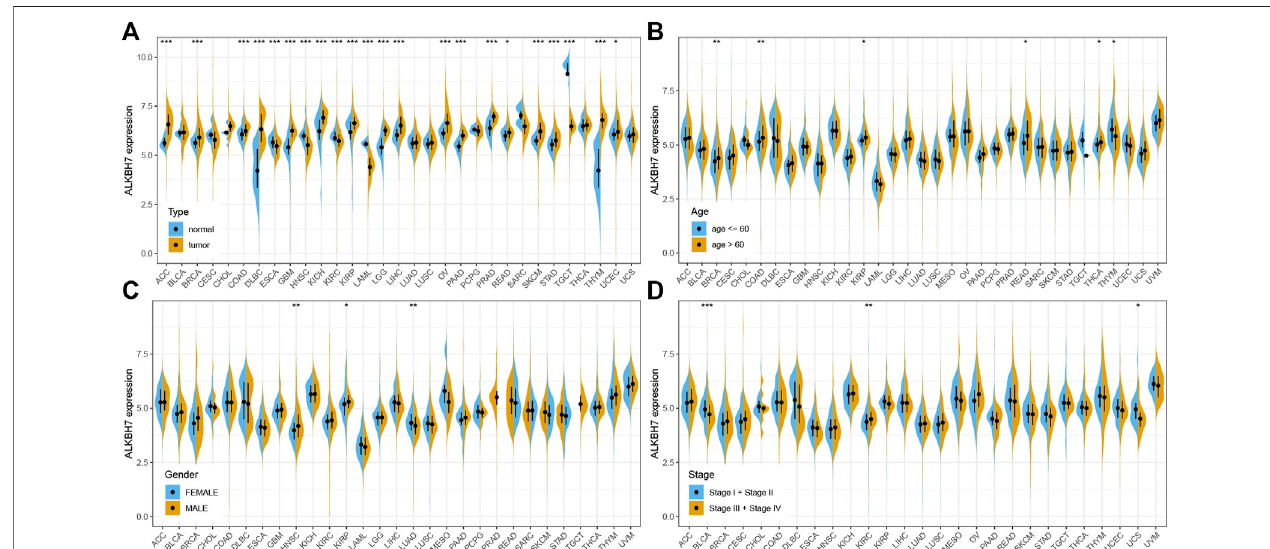
FIGURE 2 | The clinical correlation of ALKBH7 expression. (A) Differential expression of ALKBH7 in normal and tumor samples from patients with 33 cancers; the correlations of ALKBH7 with age (B) , sex (C) and stage (D) in 33 cancers. “ * ” indicates p < 0.05, “ ** ” indicates p < 0.01 and “ *** ” indicates p < 0.001.